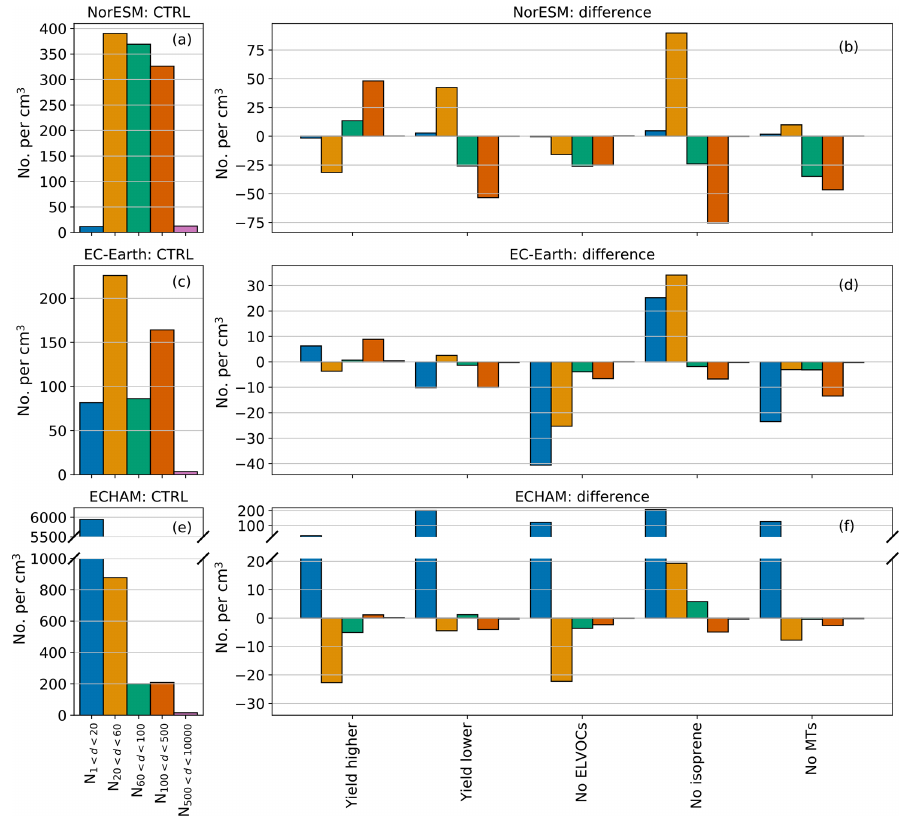
Figure 4. Bar plots of the number concentration of particles of selected sizes. In (a) , (c) and (e) the number concentrations from the CTRL simulations are shown. In (b) , (d) and (f) the absolute differences between the sensitivity simulations and the control simulations are shown for each size bin. Note that there are different scales used for the different